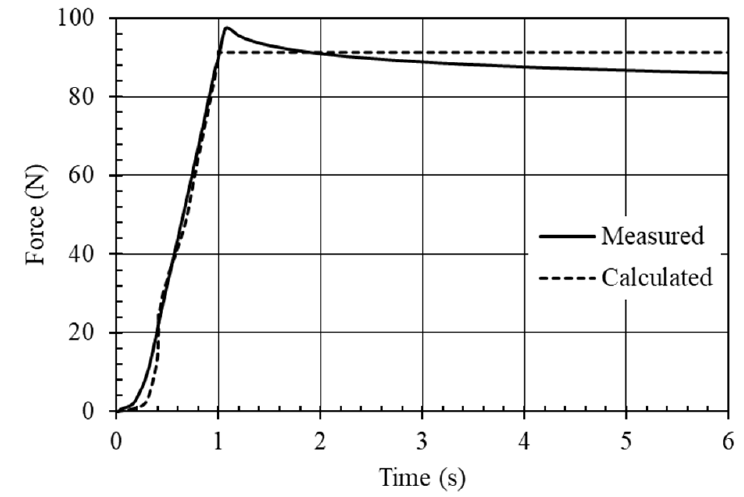
Figure 9. The force–time curves at 4 mm deflection.